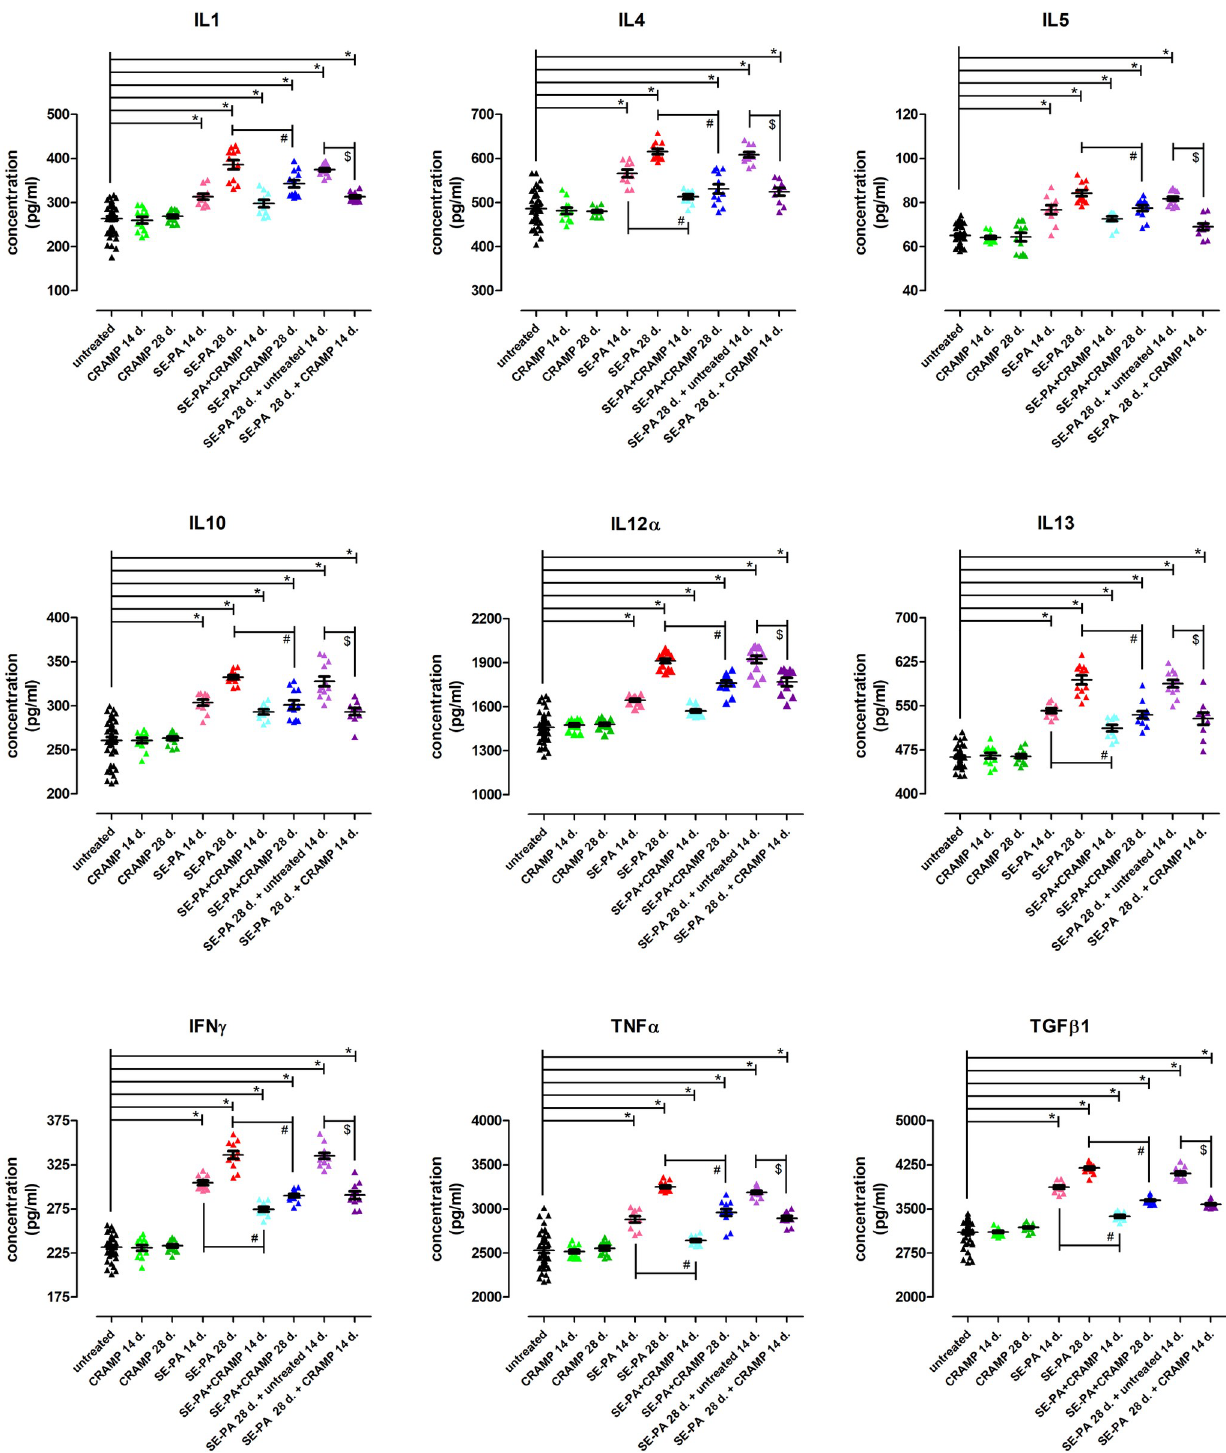
Fig 3. Changes in cytokines expression induced by cathelicidin (CRAMP) and/or Saline Extract of Pantoea Agglomerans (SE-PA) treatment. Protein concentration was investigated in homogenates of lungs collected from untreated mice and animals exposed to investigated compounds for 14, 28 or 42 days using the ELISA method. The data are presented as a mean of protein concentration ± SEM. Each research group contained 8 mice: 6 treated and 2 untreated animals. Samples were collected from all animals and analyzed in 2 replications. (control mice N = 20; treated mice per research group N = 6). � p < 0.05 vs. untreated; # p < 0.05 SE-PA+CRAMP 14 d./28 d. vs. SE-PA 14 d./28 d. (comparison within corresponding time points); @ SE-PA 28 d. + untreated 14 d. vs. SE-PA 28 d.; $ p < 0.05 SE-PA 28 d. + CRAMP 14 d. vs. SE-PA 28 d. + untreated 14 d.; one-way ANOVA test; Tuckey post-hoc test.